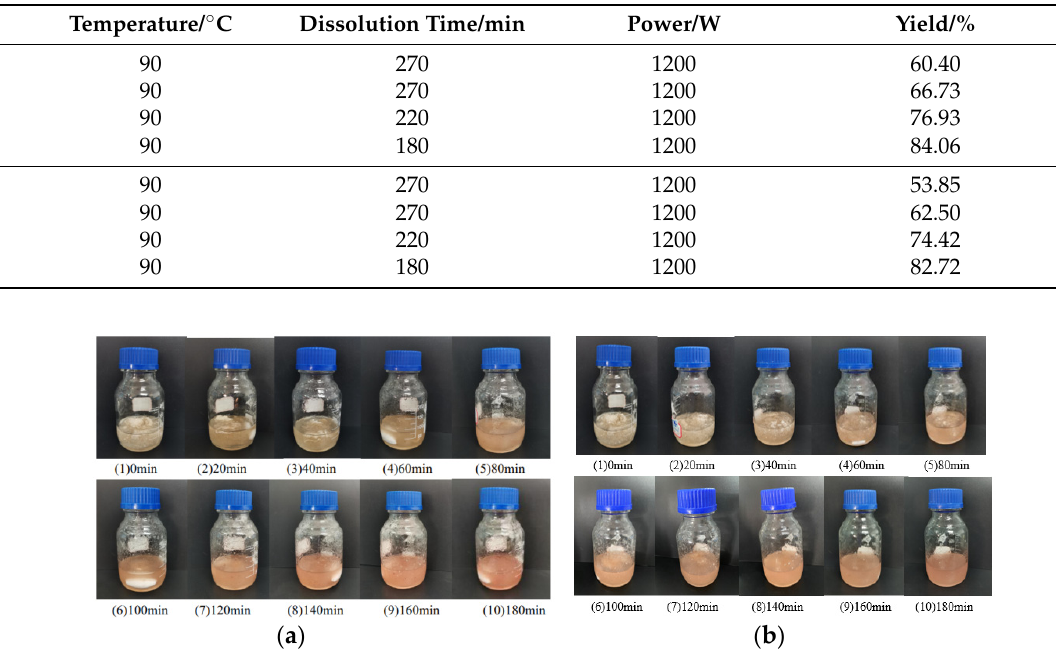
Figure 5. The dissolution process of ( a ): XM-3, ( b ) CM-3 in deep eutectic solvent.